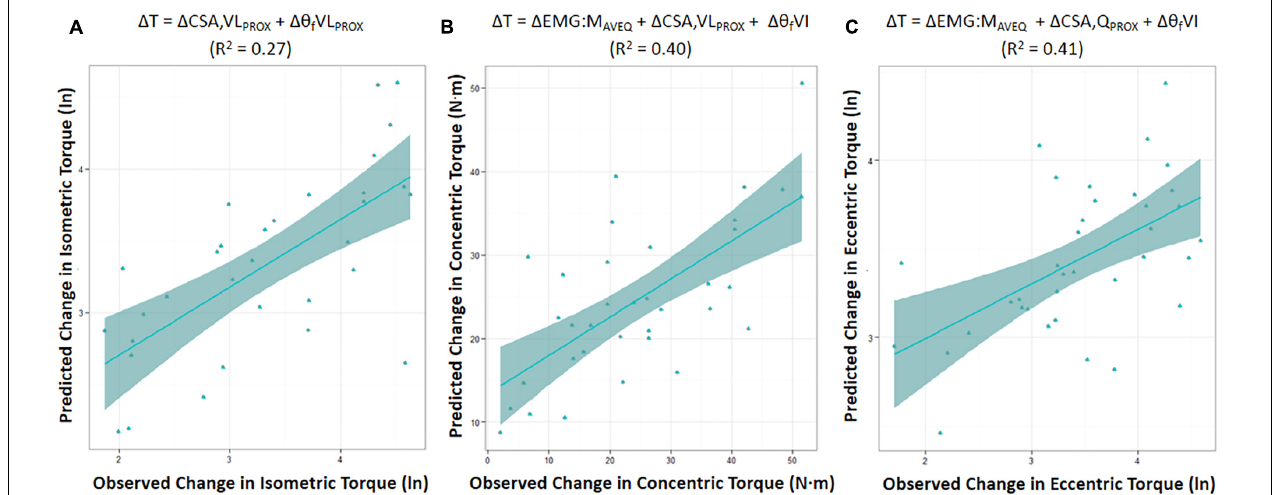
FIGURE 2 | Predicted change in torque ( (cid:49) T) was modeled based on the AIC C rankings using the best-fit model for the change in maximal isometric (A) , and isokinetic concentric (B) and eccentric (C) torque prediction. Figures show the mean ( ± SE) for each model. (ln) = the natural log of the change in torque. CSA,Q PROX and CSA,VL PROX = proximal cross-sectional area of whole quadriceps, or of vastus lateralis (VL) in isolation, respectively; EMG:M AVEQ = normalized average quadriceps (AVEQ) amplitude; θ f VL PROX and θ f VI = fascicle angle of VL obtained at proximal region, and vastus intermedius (VI), respectively; R 2 = adjusted R 2 .